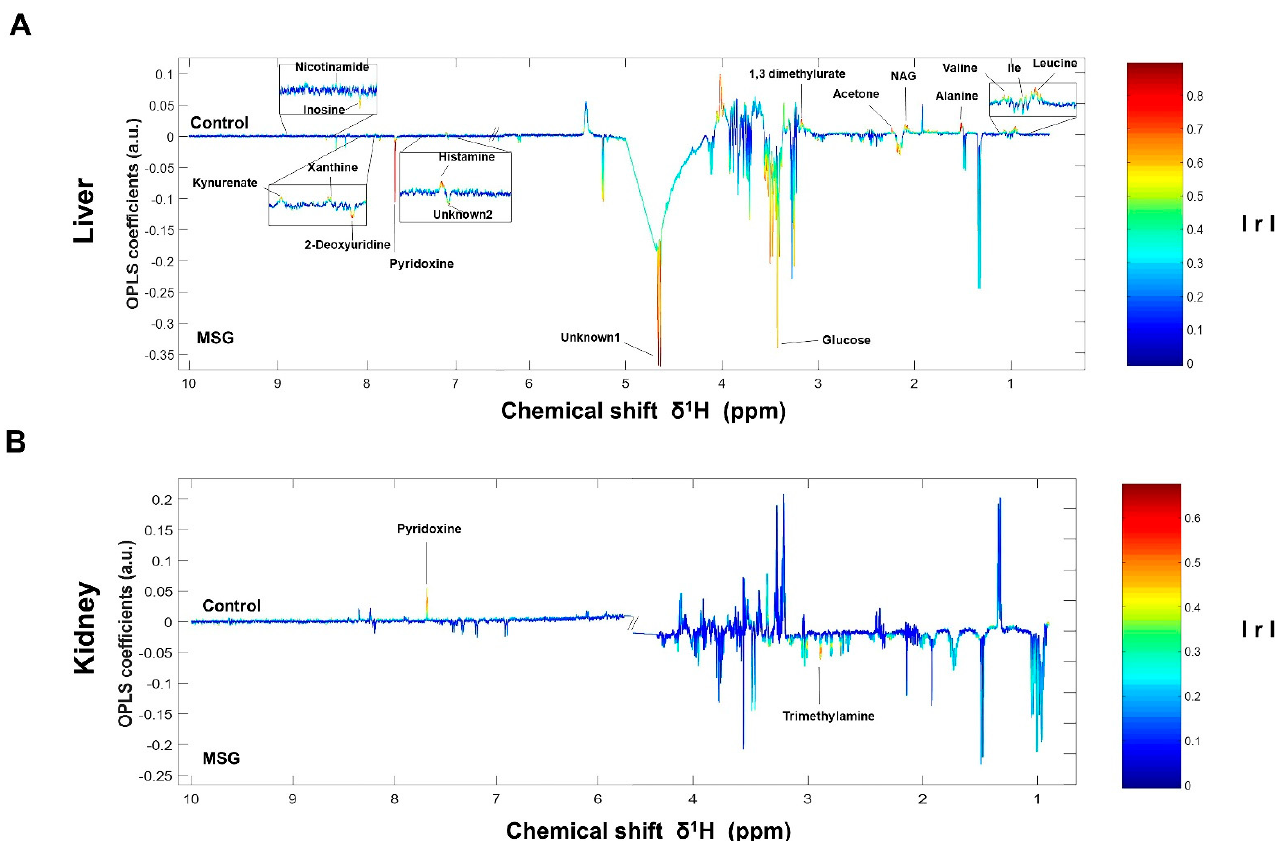
Figure 3. OPLS-corresponding coefficient loading plots of liver ( A ) and kidney ( B ). Positive and negative signals denote significant metabolites in MSG-treated rats (downwards pointing) and control groups (upwards pointing) with intensity indicated by colour (red is highly correlated and blue is weakly correlated) and also correlation per metabolite. Abbreviations: Ile, isoleucine; NAG, N -acetylglycoprotein; IrI, correlation coefficients.